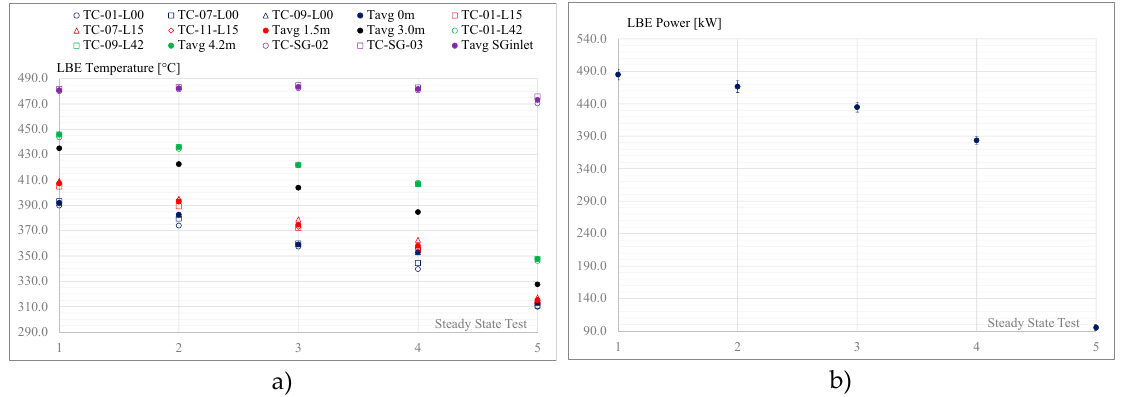
Figure 7. EF-T3: ( a ) LBE temperatures along the SG shell side for all the steady states; ( b ) LBE power and relative standard deviation at steady states .